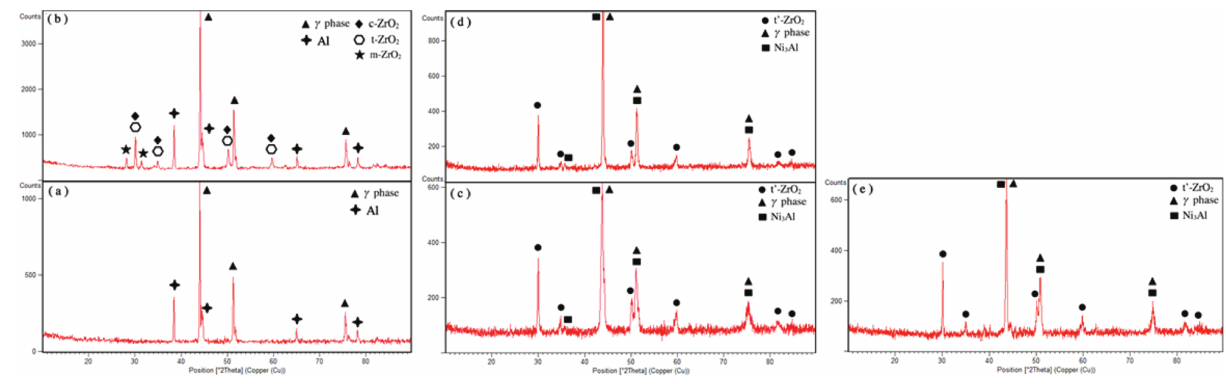
Figure 4: XRD patterns of original powder of NiCrAl (a), blended powders of outer layer (b) and AS-MC (c), GQ-MC (d), OQ-MC (e).